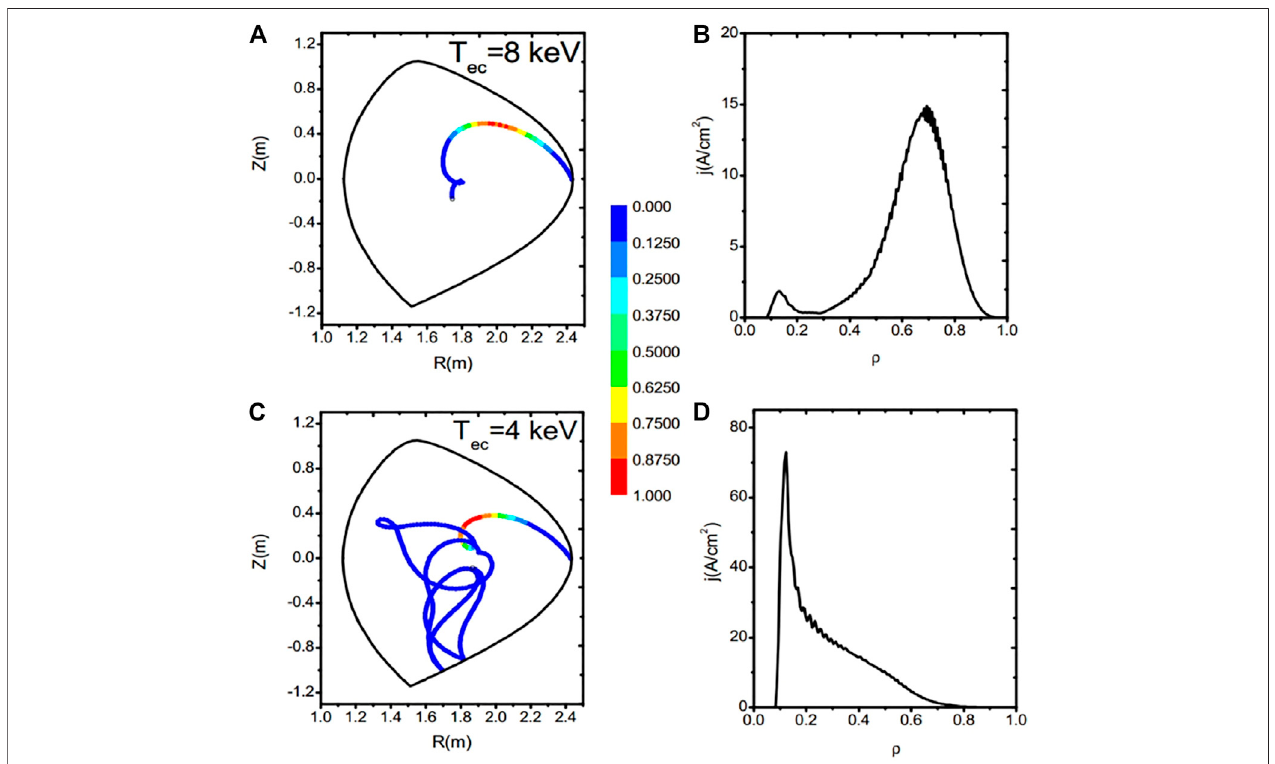
FIGURE12| Heliconwavetrajectoriesandpro fi lesofdrivencurrentfordifferentplasmaparameters: (A) and (B) , n ec (cid:3) 6.4 × 10 19 m − 3 and T ec (cid:3) 8 keV; (C) and (D) , n ec (cid:3) 4.0 × 10 19 m − 3 and T ec (cid:3) 4 keV. Reproduced from [74], with the permission of IOP